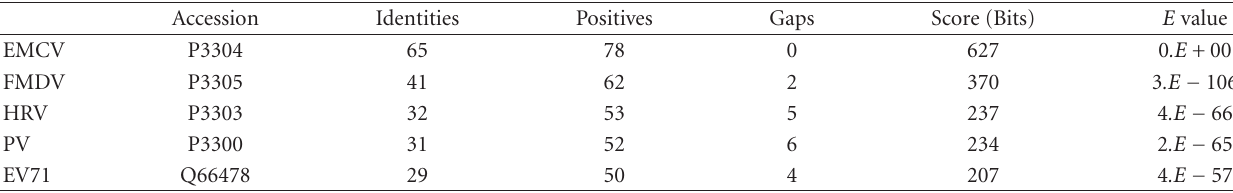
Figure 1: Genomic organization of picornaviruses with the covalently linked VPg peptide as it is packaged in the virion. The regions of the P1 (pink), P2 (blue), and P3 (brown) are shown along with the viral proteins encoded within each domain. P1 encodes capsid proteins and the P2 and P3 domains encode noncapsid proteins used for protein processing and replication. The plus-sense single stranded RNA genome is translated into a single polyprotein and then cleaved by cis and transacting viral proteases. Table 1: Amino acid sequence alignment of 3D pol from five di ff erent picornaviruses to TMEV 3D pol (Swiss Prot Accession: P13899) which was used for the query sequence. The sequence alignment was run using Blastp from National Center for Biotechnology Information (NCBI) web site for 2 or more sequences [6, 7]. Column heading definitions: Accession = the accession # from the Swiss Prot database of the aligned sequence. Identities = percentage of amino acids that are identical to the query in the alignment. Positives = the percentage of amino acid that have similar physical properties to the query in the alignment. Gaps = percentage of amino acids that create a gap to the query in the alignment. Score = Bit score. This is derived from the raw alignment score in which the statistical properties of the scoring system used have been taken into account. Because bit scores have been normalized with respect to the scoring system, they are used to compare alignment scores from di ff erent searches. E value = Expectation value. The number of di ff erent alignments with scores equivalent to or better than this alignment that are expected to occur in a database search by chance. Hence, the lower the E value, the more significant the